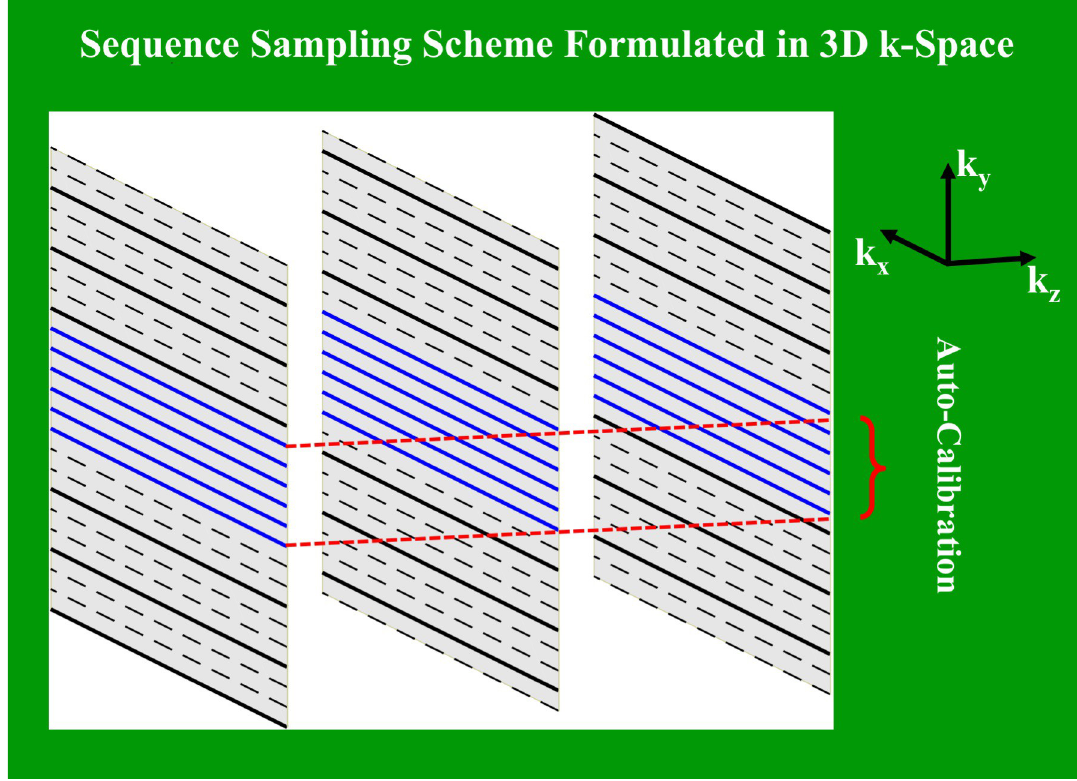
Fig 1. An illustration of the sampling scheme of the 2D SMS sequence formulated in the 3D k-space. In this 3-slice simultaneous excitation example, each solid line indicates a k-space line sampled after an RF excitation, which is also phase cycled to shift FOV among slices. The blue lines represent the auto-calibration region. In our study, only 16 calibrated lines in the center of the k-space were sampled to separate simultaneously acquired slices.